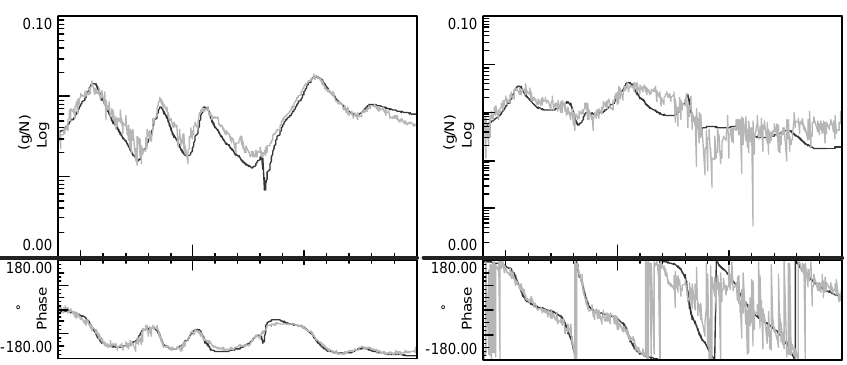
Fig. 7. Comparison of the measured FRFs (grey) with FRFs synthesised from the identified modal model (black). (Left) Sensor at the wing tip; (Right) Sensor at the back of the plane. vanes generate a sine sweep through the frequency range of interest. The forces are measured by strain gauges. Next to these measurable forces, also turbulences are exciting the plane resulting in rather noisy